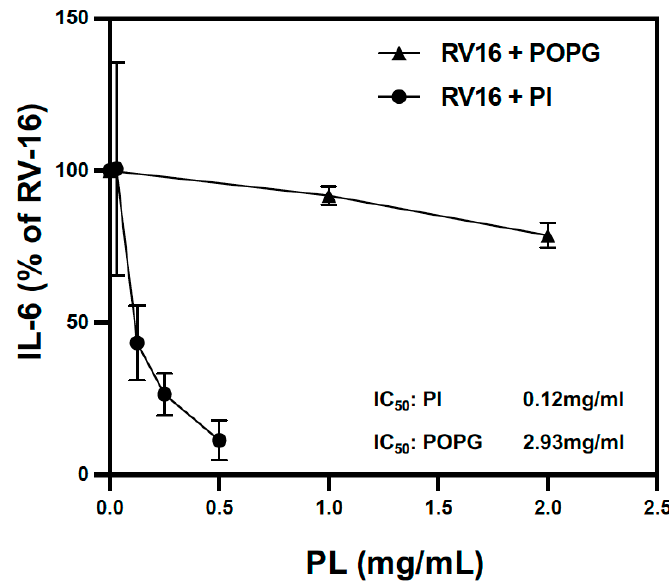
Figure 5. POPG and PI inhibited IL-6 production after RV-A16 infection in a dose-dependent manner. POPG and PI inhibited IL-6 secretion into apical media from AECs 48 h after RV-A16 infection in a dose-dependent manner. The half-maximal inhibitory concentration (IC 50 ) of POPG is 2.93 mg/mL and 0.12 mg/mL for PI. The data are shown as mean ± SD from 3 independent experiments and duplicated wells in each experiment.